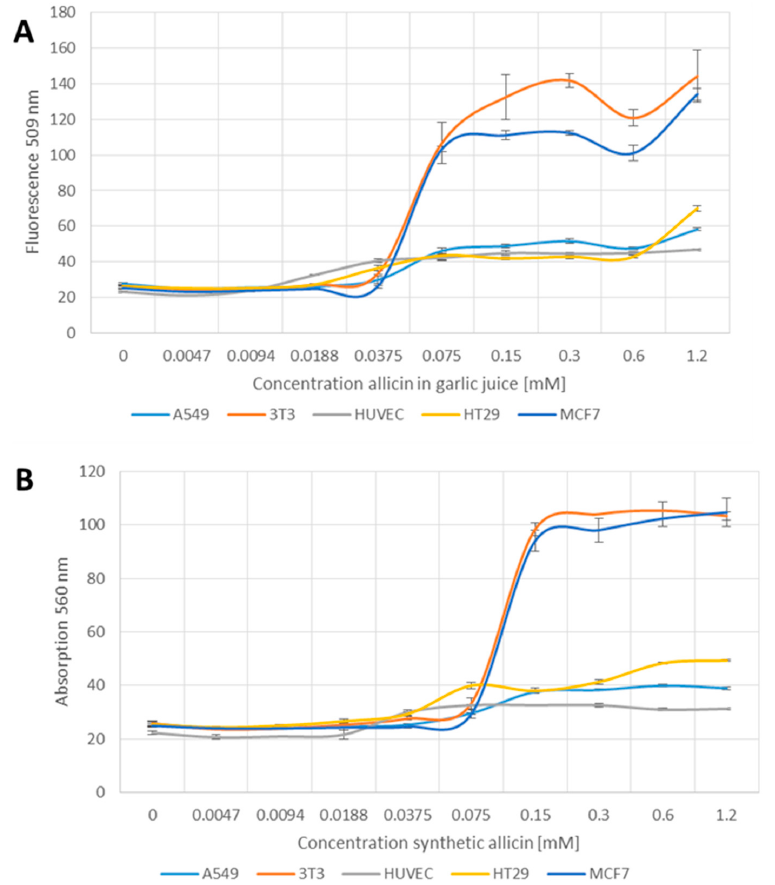
Figure 5. Induction of apoptosis by garlic juice normalized to its allicin concentration ( A ); and synthetic allicin ( B ). Different cell lines were seeded into 96-well plates (3T3 and HUVEC 1 × 10 4 cells per well, A549, MCF7, HT29 2 × 10 4 ) and treated with allicin in garlic juice or chemically synthesized for 1 h. After washing the cells, YO-PRO1 iodide was added to a final concentration of 1 µ M and incubated for 20 min at room temperature. Relative fluorescence was measured at 509 nm after excitation at 490 nm. All data points are means of three replicates; error bars represent standard